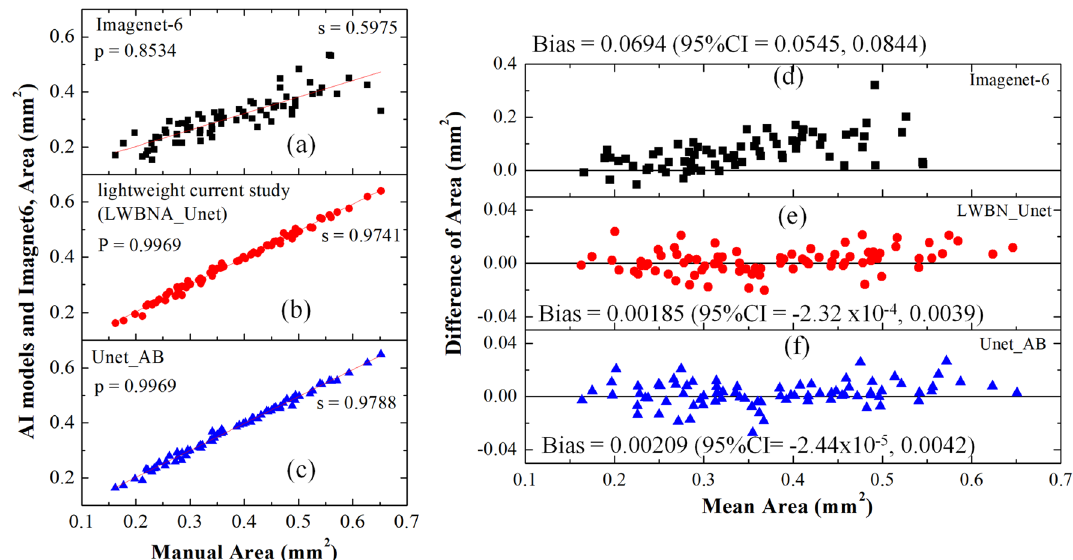
Figure 4. Comparison of manually, and automatically measured FAZ areas ( a ) by a commercial software imagenet-6, ( b ) model developed in current study, LWBNA_Unet, ( c ) Unet_AB, and ( d – e ) are the corresponding Bland–Altman plots i.e., the difference and mean of areas with manual